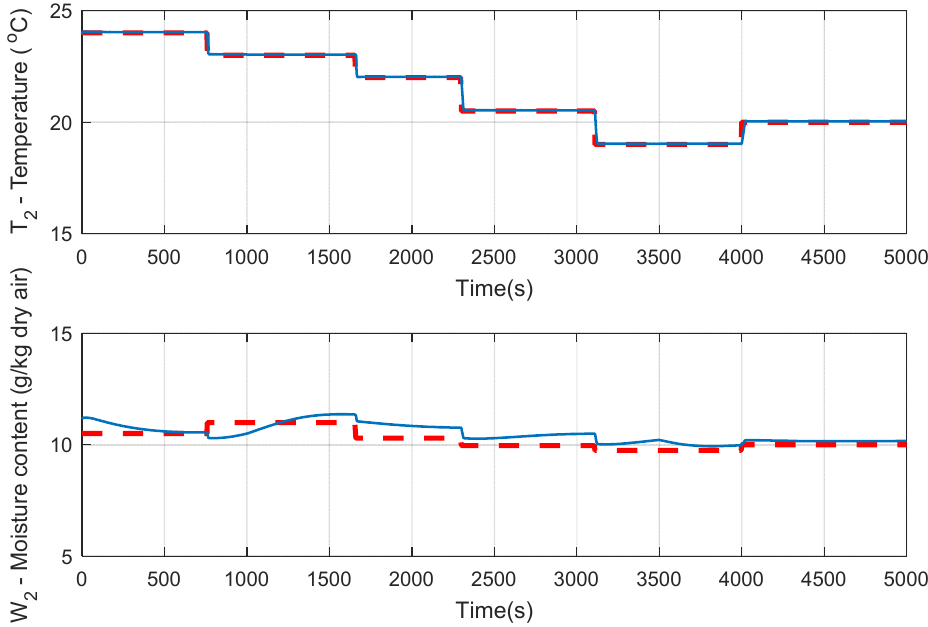
Figure 6. Tracking performance of VS DX A/C system with internal and external disturbances.